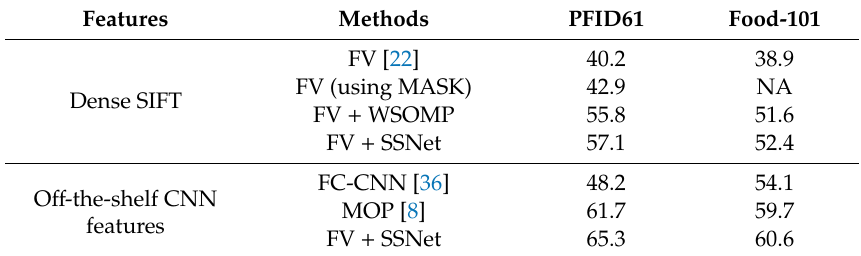
Table 4. Comparison of di ff erent image encoding methods using Dense SIFT, o ff -the-shelf CNN features on PFID61 and Food-101 datasets (MAP in percentage).